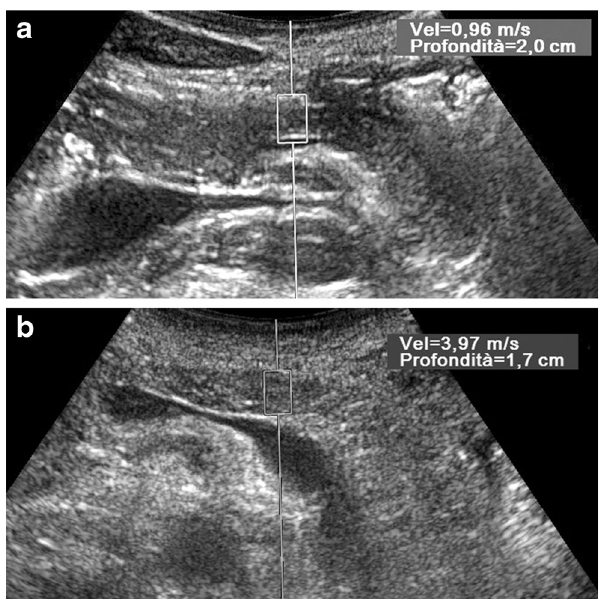
Fig. 13 ARFI evaluation of the pancreas. Axial US scans with ROI placed in the pancreatic body. The SWV value is much lower (0.96